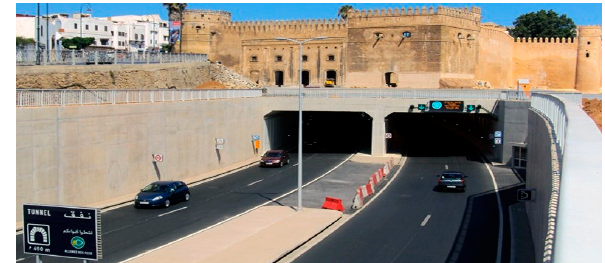
Figure 1. The “Oudaya” Tunnel in Rabat (Morocco).